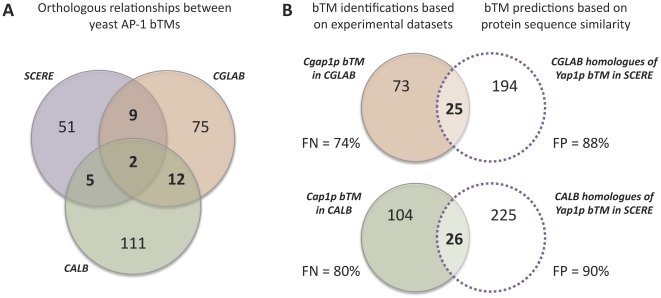
Cross-species comparison of the S. cerevisiae, C. glabrata and C. albicans bTMs based on sequence orthology and homology.(A) Yeast AP-1 bTMs were defined using the general protocol presented in Figure 1. They are represented here using a Venn diagram with the following color code: purple circle for Yap1p bTM (SCERE), orange circle for Cgap1p bTM (CGLAB) and green circle for Cap1p bTM (CALB). Overlaps between bTMs represent the number of orthologous relationships (inferred with the INPARANOID algorithm, see Materials and Methods) between them. Only 11 orthologous genes were thus identified between the SCERE and CGLAB AP-1 bTMs (16%), 7 between the SCERE and CALB AP-1 bTMs (10%) and 14 between the CGLAB and the CALB AP-1 bTMs (14%). Considering the global amount of orthologous genes between the three species (more than 60%), these values were surprisingly low and suggested that in yeasts, there exist functional similarities between proteins that are not reflected in sequence orthology. (B) Comparison between the Cgap1p (in C. glabrata) and the Cap1p (in C. albicans) bTMs identified based on experimental datasets, and the bTMs predicted based on protein sequence similarity with the Yap1p (in S. cerevisiae) bTM, i.e. functional annotation transfer from the model yeast S. cerevisiae to the Candida species. The original Cgap1p and Cap1p bTMs are represented using respectively orange and green circles, whereas the predicted bTMs are shown with circles surrounding by purple dashed lines. The predicted bTMs were obtained searching in Candida genomes for homologous proteins with the Yap1p bTM using the BLAST algorithm (see Materials and Methods). Overlaps between original and predicted bTMs represent the number of genes in common. Considering the Candida bTMs identified using experimental datasets as a reference, false positive (FP) and false negative (FN) rates associated to the bTMs predictions were calculated and are shown here. In each species, FN and FP represent important error rates (more than 70%), if one tries to defined AP-1 bTMs in Candida species directly transferring information from the well-studied S. cerevisiae species.